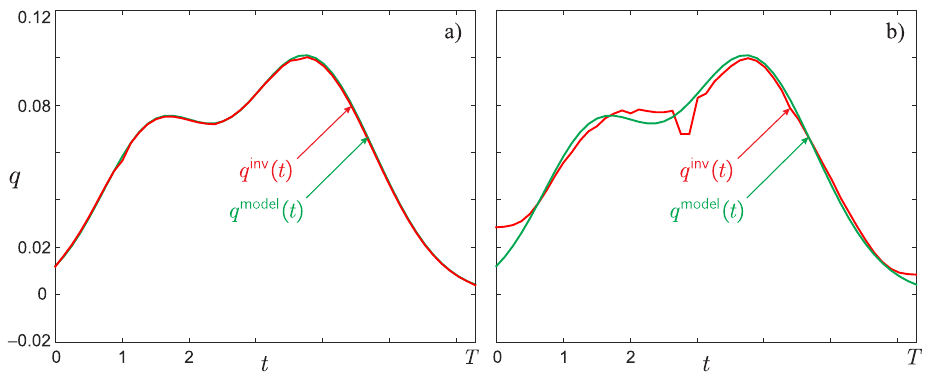
( t ) simulated for a set of δ 1